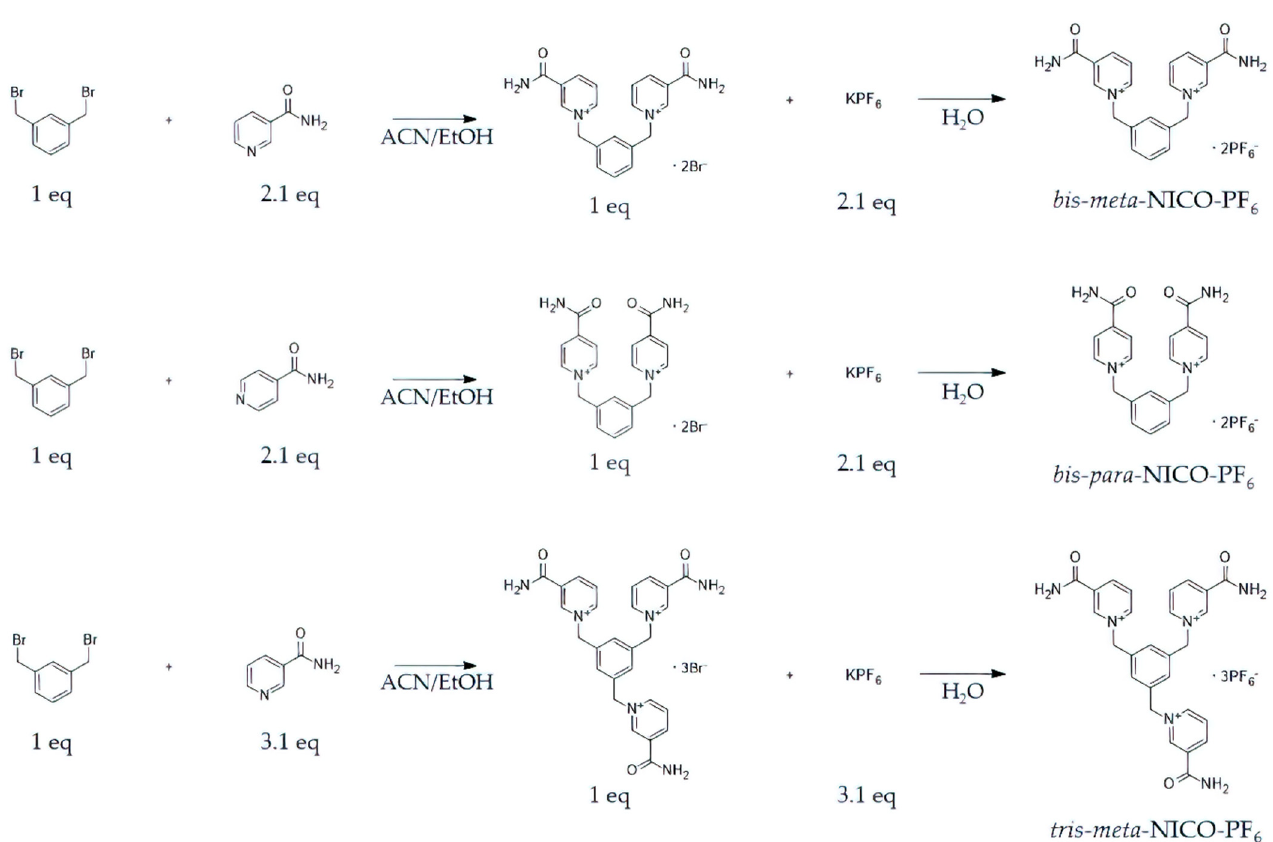
Scheme 1. Synthetic scheme of phosphate ionophores with nicotinamide functional groups. The symbol “eq” stands for equivalent weight.